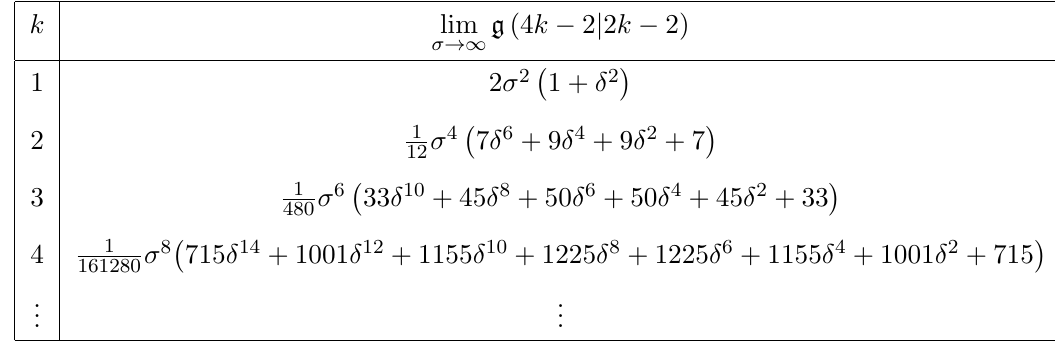
Table 2 . Behaviour of g (4 k